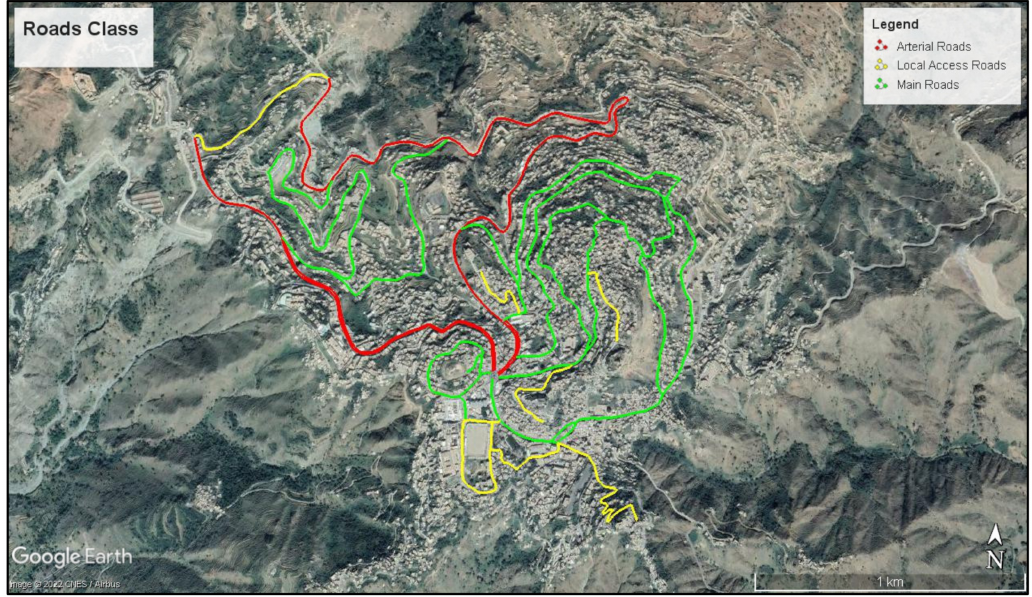
Figure 3. Hajjah road network with road classes shown on the Google Earth